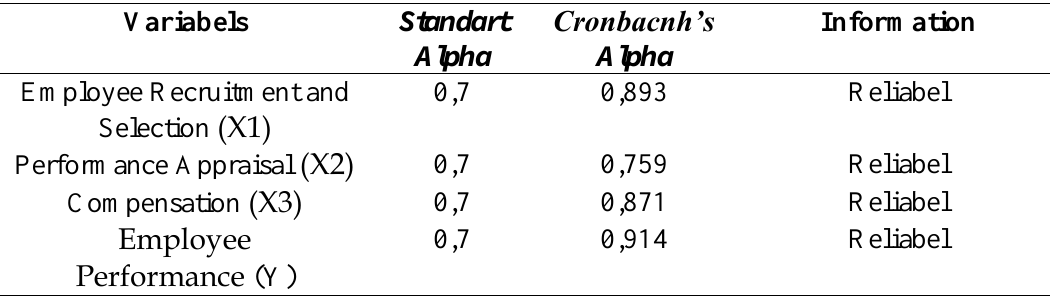
Reliability Test